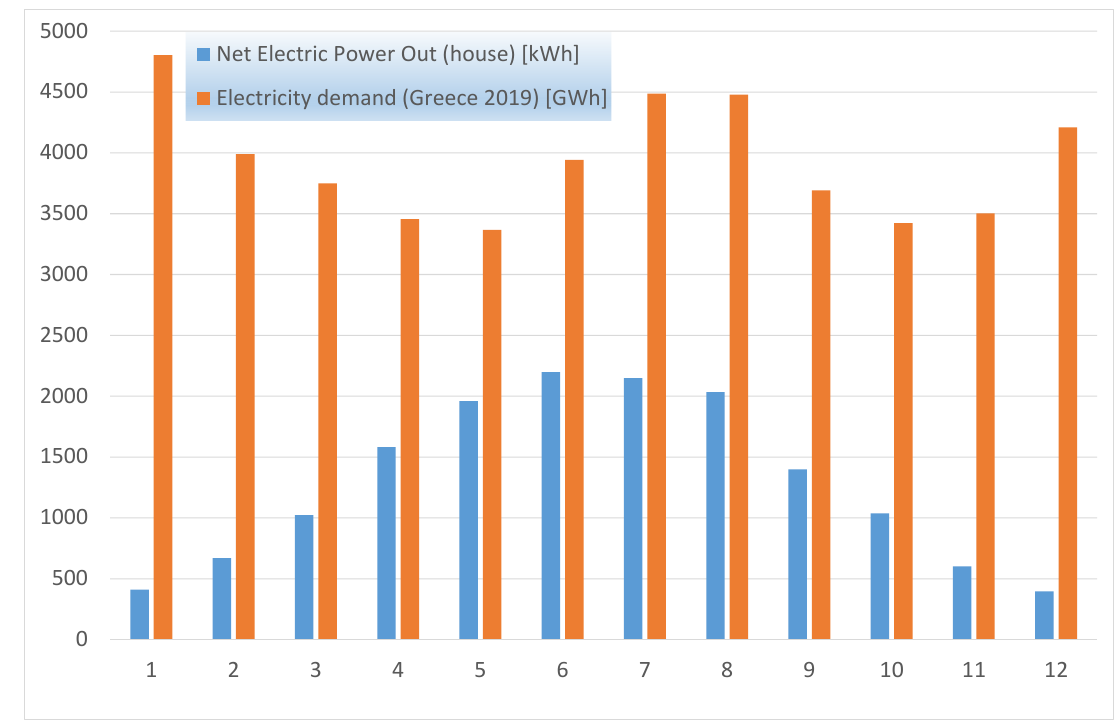
Figure 11. Monthly variation of net electric power sent to the network by the maximum capacity of the house’s PV installation (48 modules). Total monthly electricity demand for Greece (2019) is shown for comparison.